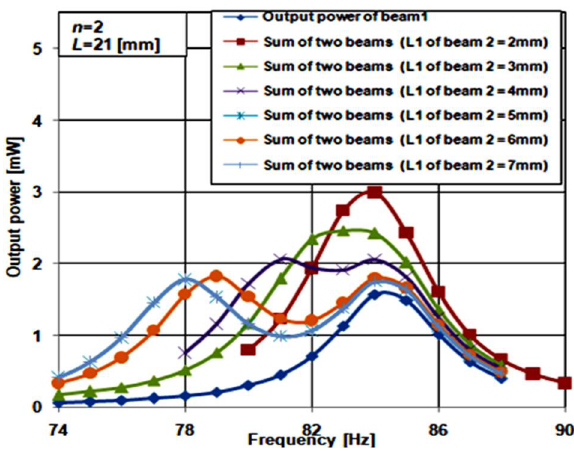
Figure 7. Frequency response of beam 1 and summation of beam 1 and beam 2 ( L 1 of beam 2 varies from 2 mm to 7 mm).